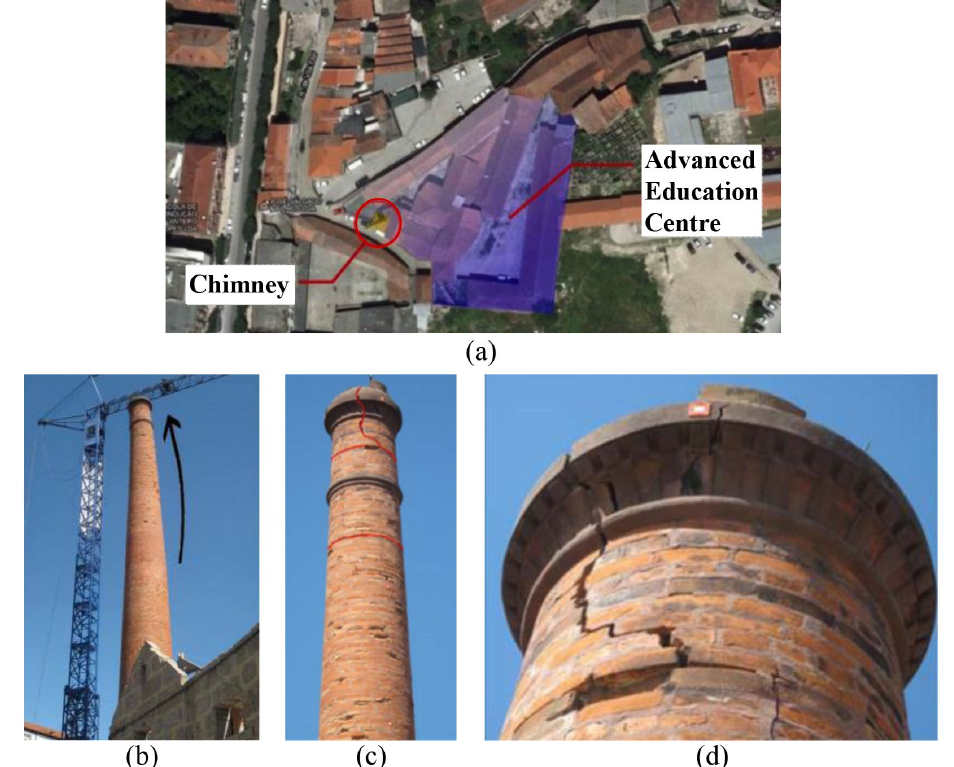
Figure 1. Location of the chimney (a) and view of the structure before the accident: (b) permanent deformation; (c-d) cracks triggering the disconnection of the top